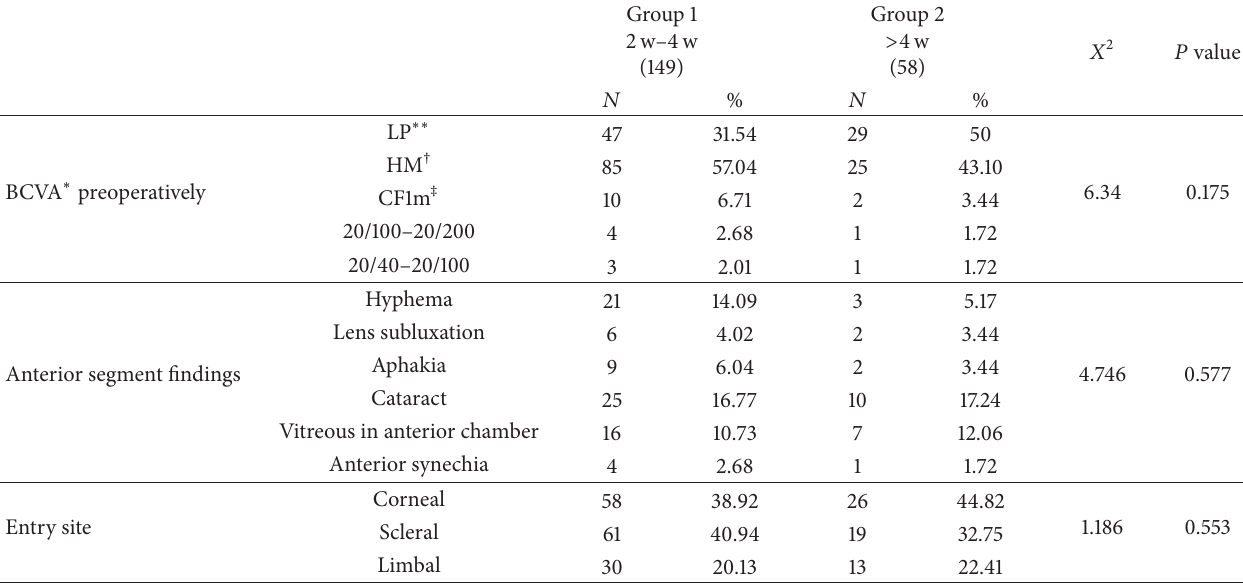
Table 1: Preoperative data of the patients.